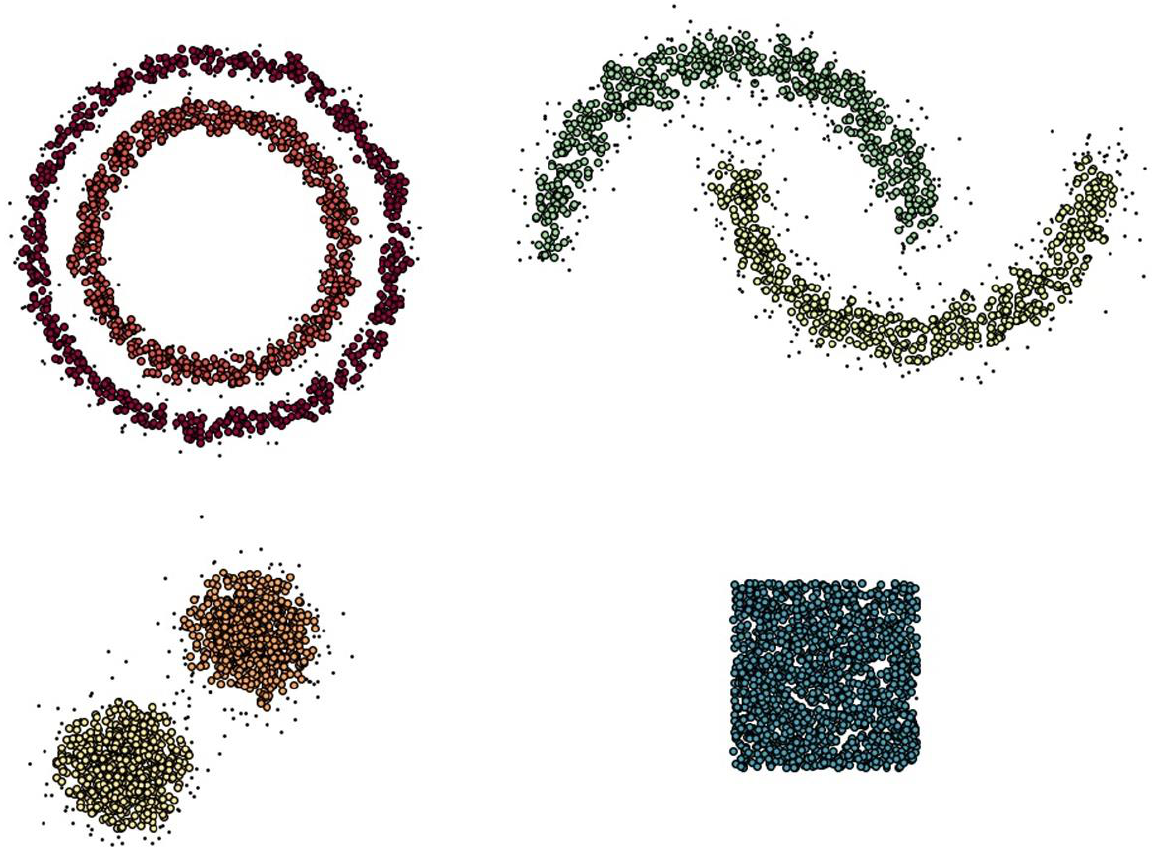
Figure 4. The result of clustering by the DBSCAN algorithm.